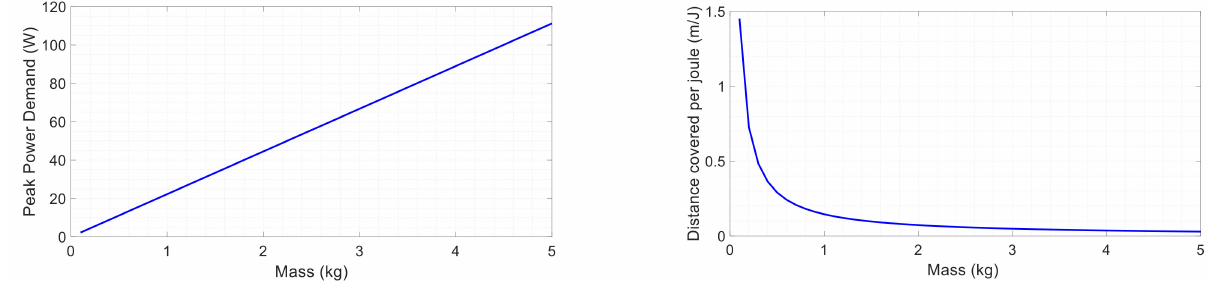
Figure 19. Peak power demand ( left ), and horizontal distance covered per joule consumed ( right ) when ω = 2 π , r = 0.2 m and varying mass.